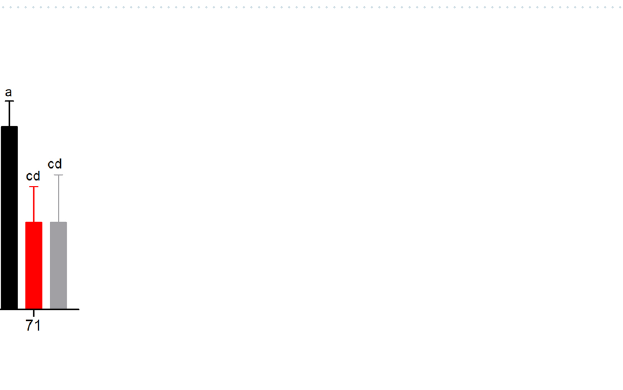
Figure 4. Max intensity projections of representative CLSM stacks acquired during the erosion test. The biofilms grown at three shears (1, 6.5 and 11.0 mPa) were subjected to four (9, 18, 36 and 71 mPa) increasing shears (10 min for each shear) and the biovolume of the biofilms still present in the flow cell was measured after each step by CLSM in order to test the cohesiveness of C. vulgaris biofilms. Images are shown for the biofilms grown at 1 and 11.0 mPa and the brightness has been adjusted for visual purposes.